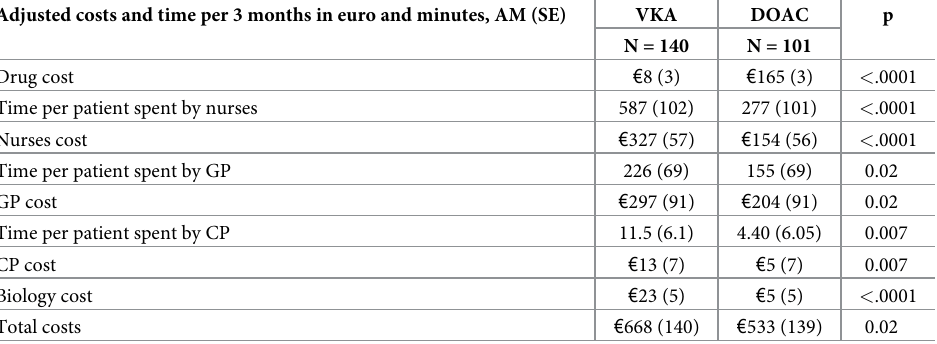
Table 3. Costs and time spent by nurses and physicians during 3 months according to DOAC and VKA treatments. Adjusted costs and time per 3 months in euro and minutes, AM (SE) VKA DOAC p N = 140 N = 101 Drug cost € 8 (3) € 165 (3) < .0001 Time per patient spent by nurses 587 (102) 277 (101) < .0001 Nurses cost € 327 (57) € 154 (56) < .0001 Time per patient spent by GP 226 (69) 155 (69) 0.02 GP cost € 297 (91) € 204 (91) 0.02 Time per patient spent by CP 11.5 (6.1) 4.40 (6.05) 0.007 CP cost € 13 (7) € 5 (7) 0.007 Biology cost € 23 (5) € 5 (5) < .0001 Total costs € 668 (140) € 533 (139) 0.02 AM (SE), mean (standard error) adjusted for age, sex, cardiovascular disease (i.e., hypertension, heart failure, coronary heart disease, stroke and TIA), dementia, depression, anticoagulant indication (i.e., atrial fibrillation, pulmonary embolism, deep vein thrombosis and heart valve prosthesis); VKA, vitamin K antagonists; DOAC, direct oral anticoagulants; GP, general practitioner; CP, coordinating